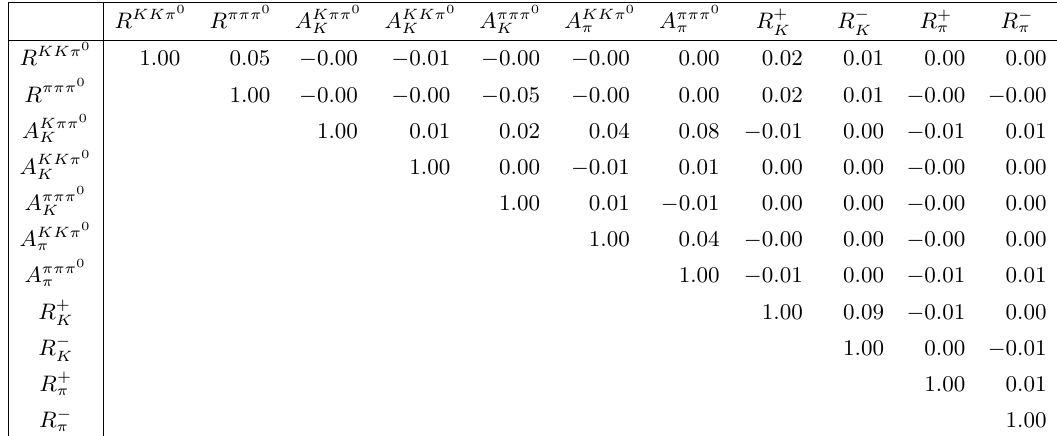
Table 3 . Correlation matrix for statistical